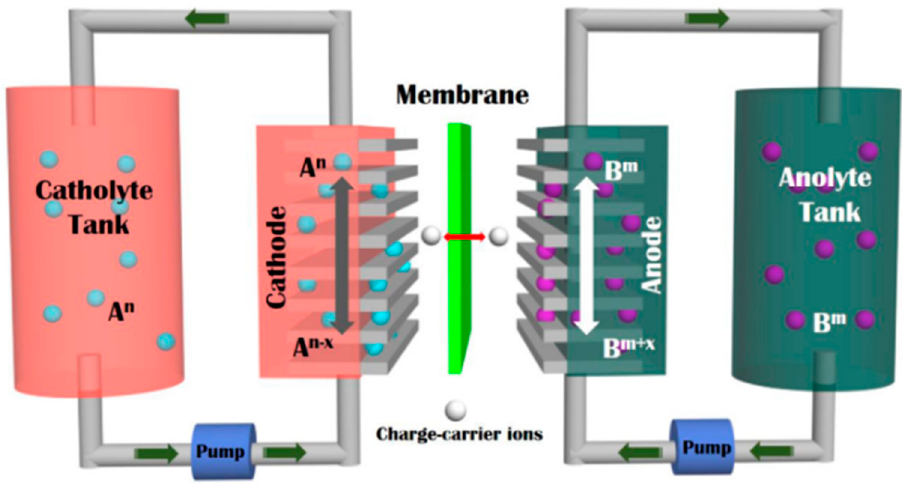
Figure 1. Schematic showing a typical redox flow battery with the tanks containing the dissolved catholyte (also known as posolyte) and the anolyte (also known as negolyte) materials. The electrolytes at each electrode are circulated using pumps. Reprinted with permission from Ref. [4]. 2022, Elsevier.